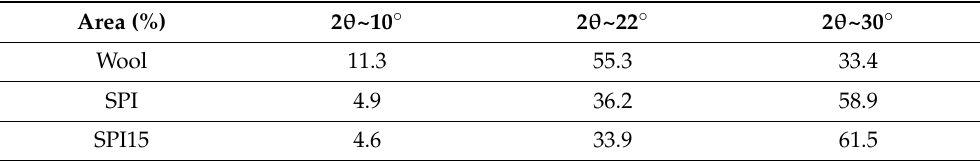
Table 3. Values of the area under the deconvoluted XRD peaks for neat sheep wool, neat SPI, and SPI15 biocomposites.